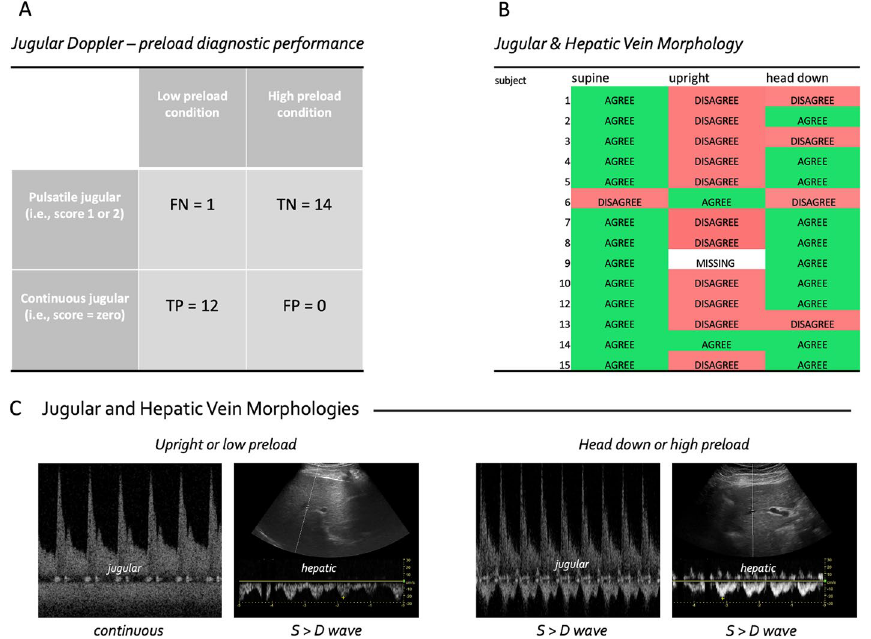
Fig. 2 Effect of gravitational preload change on jugular and hepatic veins. A 2 for jugular morphology versus preload, FN is false negative, TN is true negative, TP is true positive and FP is false positive B agreement between the jugular vein and hepatic vein morphologies at different preload conditions. C Examples of jugular and hepatic vein Doppler at low (left most) versus high (right most) preload